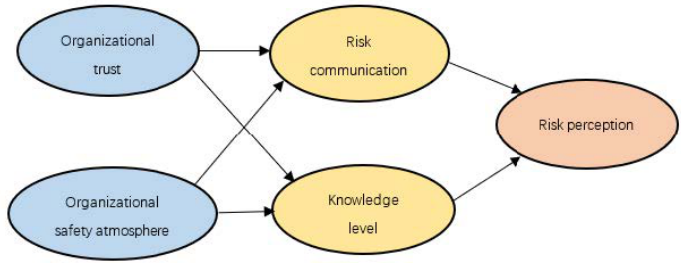
Figure 2. Model 1 of mediation effect path.